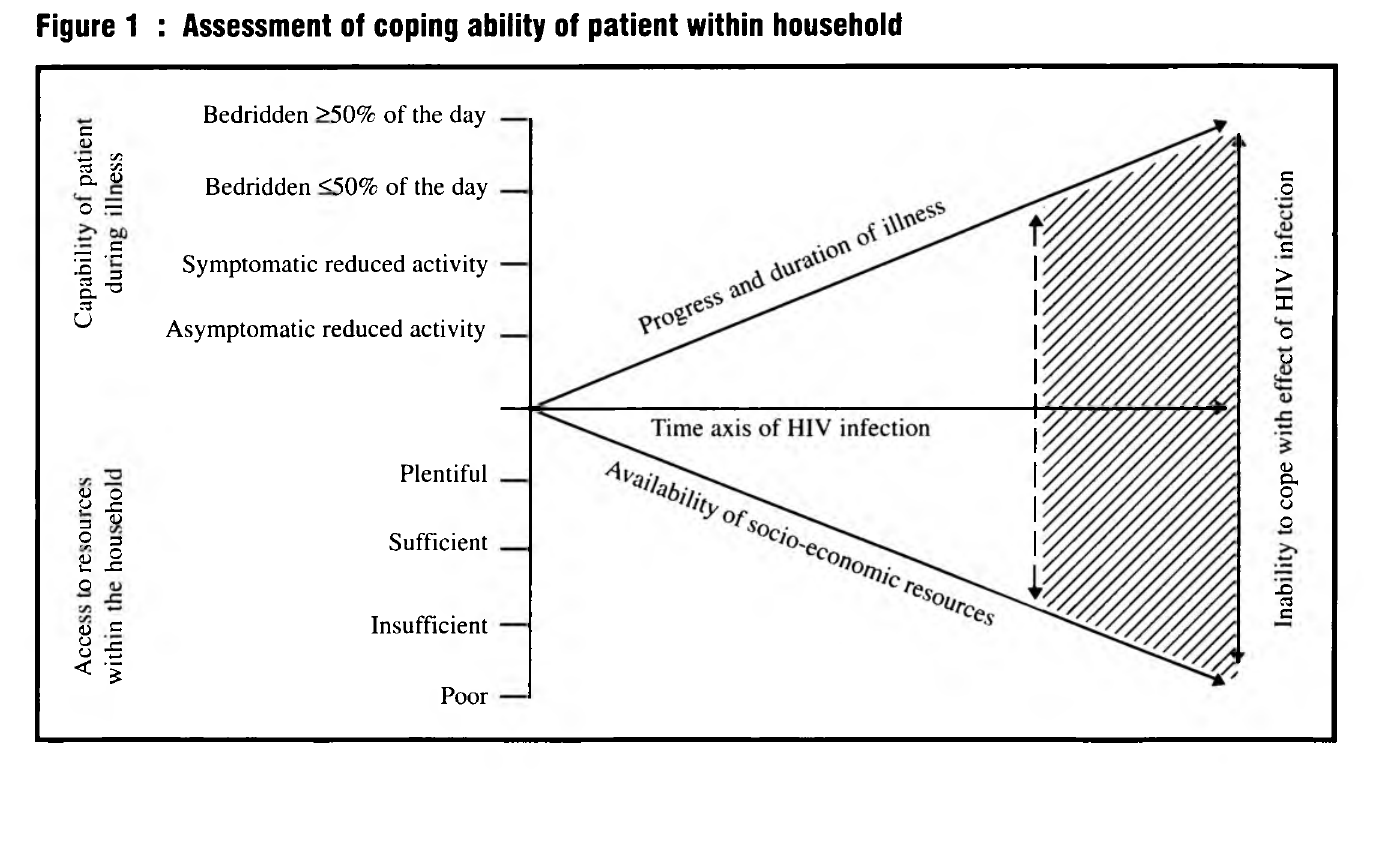
Figure 1 : Assessment of coping ability of patient within